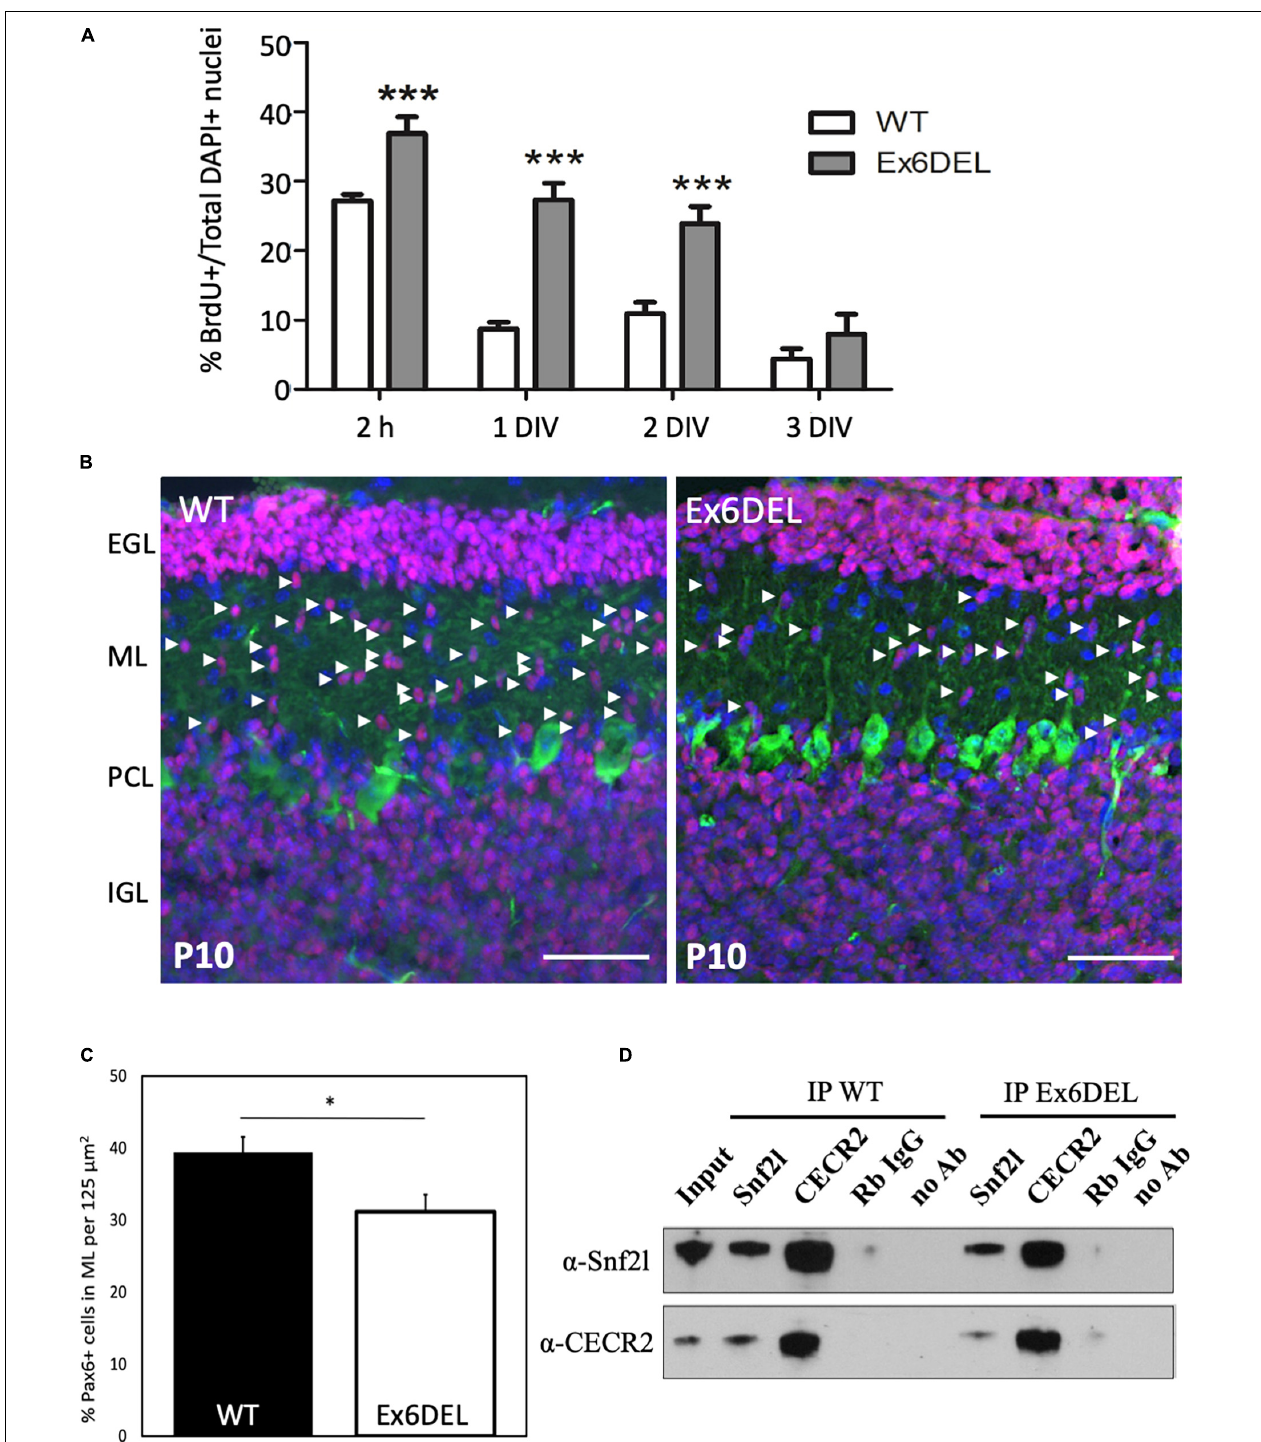
FIGURE 2 | Ex6DEL cultures show delayed differentiation. (A) Graph depicting the fraction of BrdU + cells in WT (white bars) and Ex6DEL (gray bars) GNP cultures at the specified times. Cultures were pulsed with BrdU for 2 h prior to harvesting cells for analysis. ( n = 4 independent experiments; five images per coverslip used for quantification). *** p < 0.001. (B) P10 cerebellar sections from WT and Ex6DEL mice stained for committed granule neurons (Pax6, magenta), Purkinje neurons (Calbindin, green) or all cell nuclei (DAPI, blue). Arrowheads indicate the migrating postmitotic granule neurons. EGL, external granule layer; ML, molecular layer; PCL, Purkinje cell layer; IGL, inner granule layer. Scale bar, 50 µ M. (C) Plot of the percentage of Pax6 + cells within the ML. ∗ p < 0.05. (D) Immunoblot analysis of cerebellar extracts from WT and Ex6DEL mice co-immunoprecipitated for Snf2l, Cecr2, or a control rabbit antibody (Rb IgG).